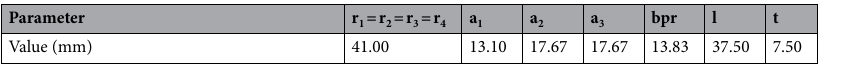
Table 1. Final dimensions of cavity’s